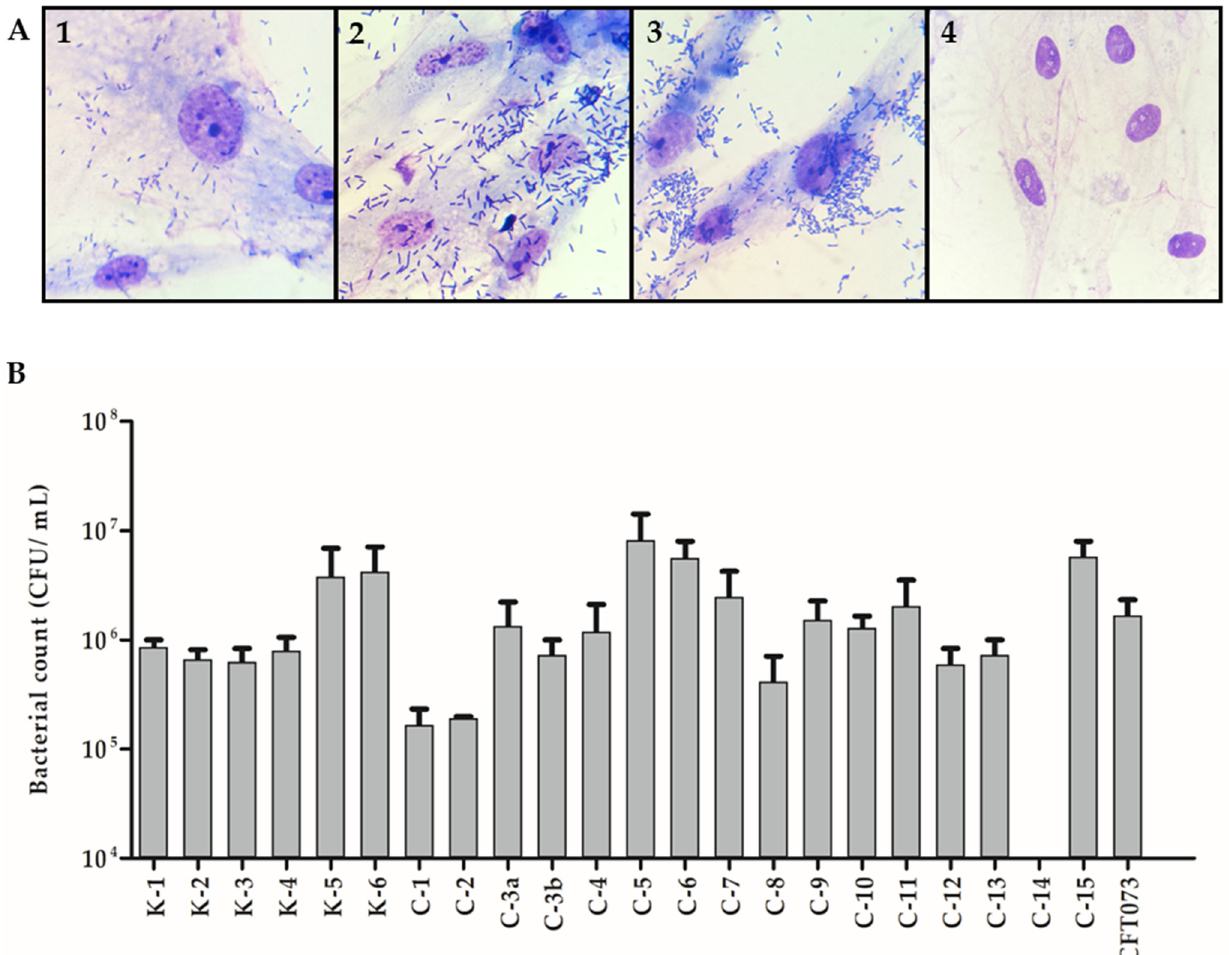
Figure 3. Adherence of Escherichia coli strains isolated from eye infections to human corneal epithelial cells (HCECs). ( A ) Representative examples of different levels of E. coli strains adherence to HCEC under oil immersion light microscopy: (1) strain C-8, low adherence; (2) strain C-15, high adherence; (3) strain C-6, high adherence and aggregative adherence pattern; (4) non-infected human corneal epithelial cells. ( B ) Bacterial adherence based on quantitative assay results. The prototype strain CFT073 was used as a control for ExPEC adherence.